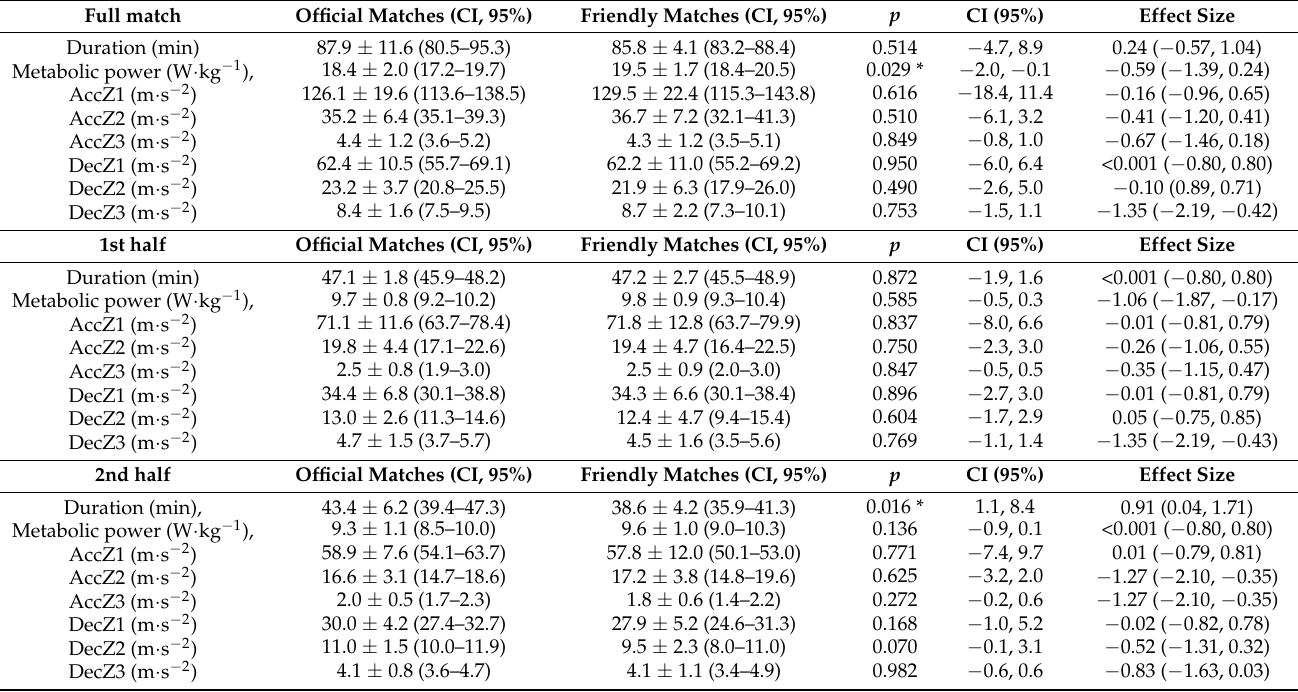
Table 2. Comparison of full match day, first half, and second half data between official and friendly matches per squad average, mean ± standard